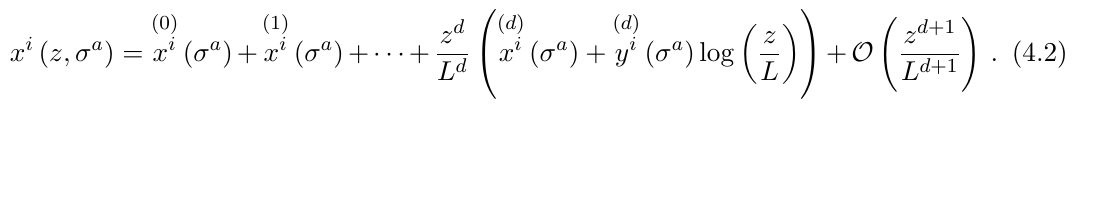
Figure 5 . Different boundary subregions, R = R L ∪ R R and R 0 = R 0 boundaries, i.e., ∂ R = ∂ R 0 . The entanglement entropy and the RT surface remains the same for both subregions. However, the extremal surfaces B and B 0 (denoted by the orange regions) are different and hence they produce different islands e B and e B 0 on the brane (represented by the blue slice). The QES on the brane is unchanged and hence ∂ e B = ∂ e B 0 = σ on the asymptotic boundary represent the causal domain of R ( e B ). The subregion R 0 may be any spacelike surface in this causal domain. Similarly, e B 0 will always lie within the causal domain of the brane (denoted by the pink